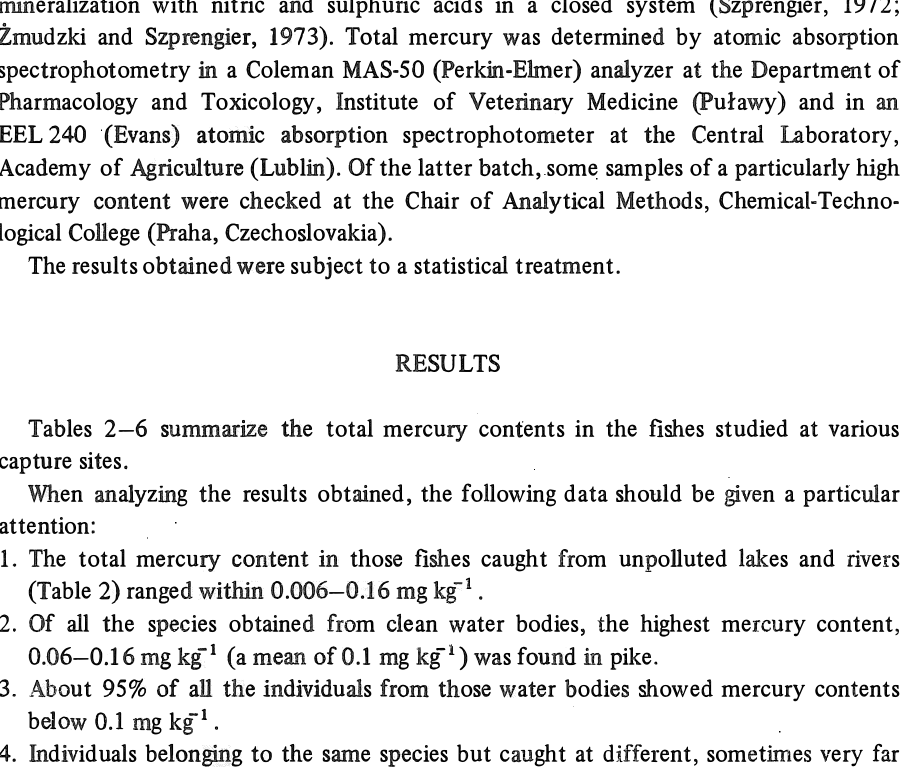
Total mercury content in muscles of fishes caught from the Vistula 1;.ear Cracow Fish weight No. Species